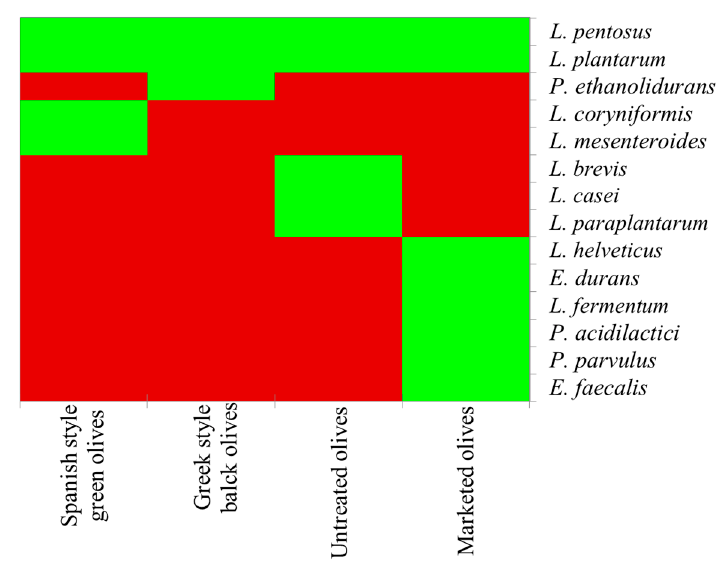
Figure 1. LAB species detected in table olives. The green color indicates the presence of the species, while red its absence. Spanish-style olives are debittered through the addition of lye. In the Greek style, olives are put directly in brine and oleuropein is removed by the enzymatic activities of indigenous microorganisms.